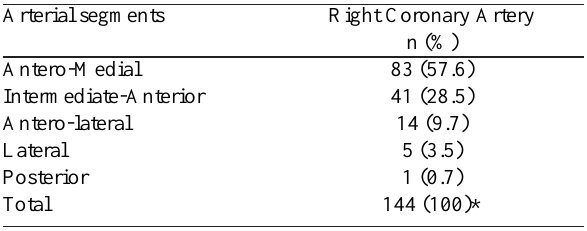
Table 3. Sinoatrial node artery originated from different segments of